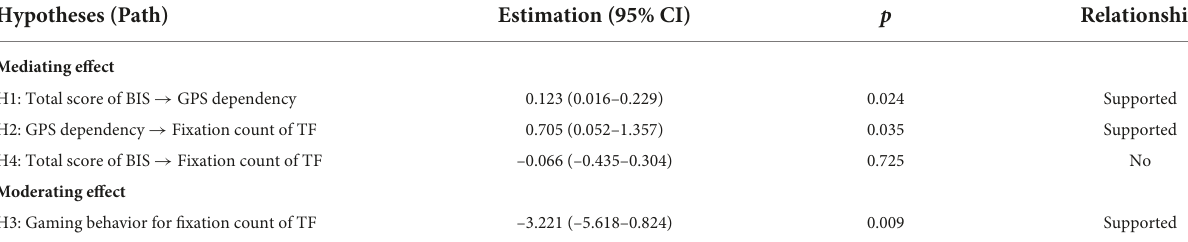
TABLE 3 Hypothesis validation